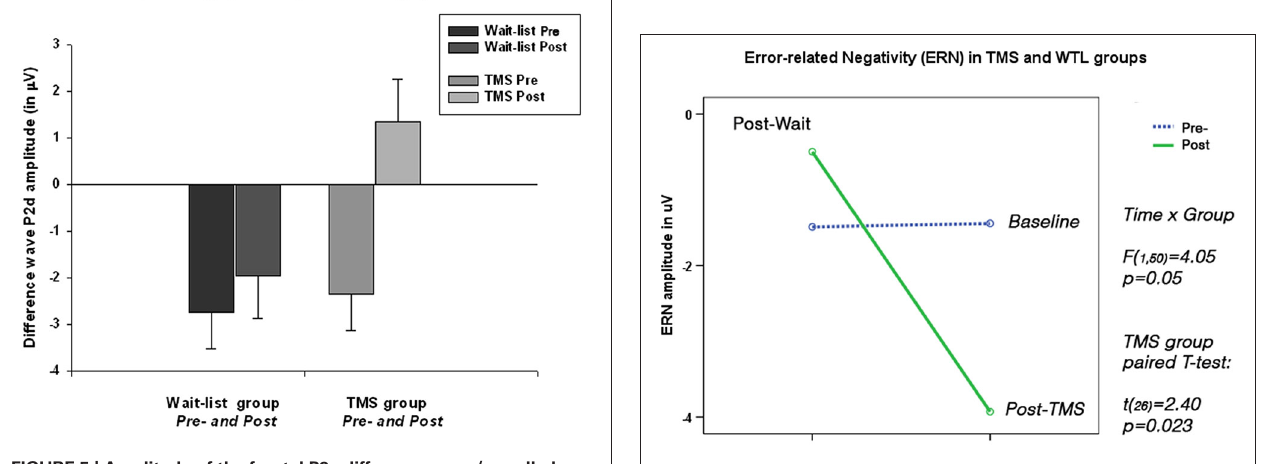
FIGURE 5 | Amplitude of the frontal P2a difference wave (so called P2d = [P2a to targets minus P2a to non-targets] ) across both hemispheres shows Time X Group interactions effect ( F = 4.11, p = 0.048) . Difference wave (P2d) was negative at the baseline in both groups (i.e., lower amplitude to targets as compared to non-targets), but becomes positive post-TMS. Increase of P2d was significant in the TMS group ( t = 2.52, p = 0.018).